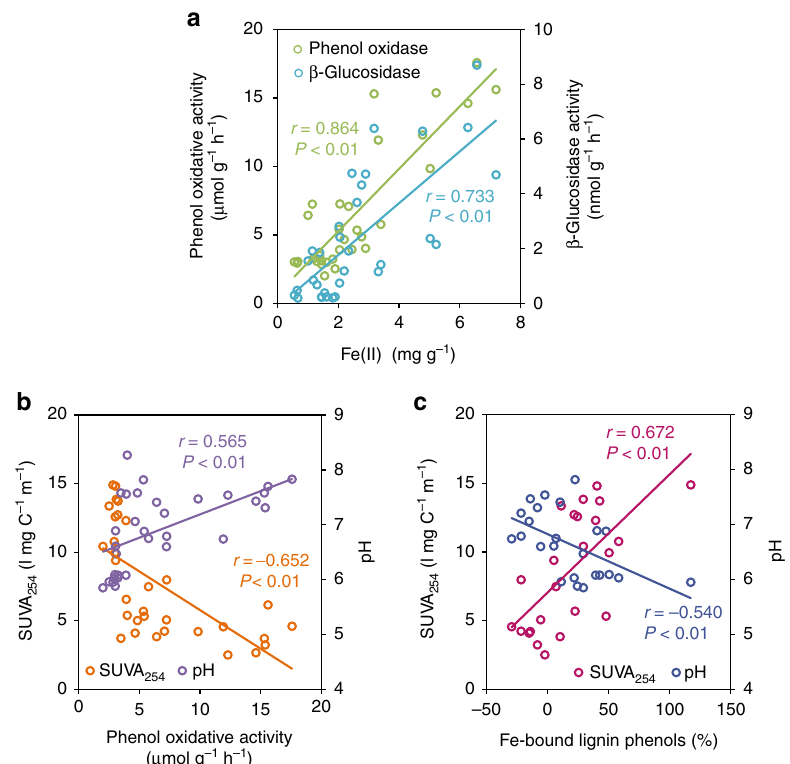
Figure 4 | Variables influencing enzyme activities and iron-bound lignin phenols in the alpine wetland soils. ( a ) Correlations of phenol oxidative and b -glucosidase activities with ferrous iron [Fe(II)] content; ( b ) correlations of soil pH and specific ultraviolet absorbance at 254nm (SUVA 254 ) in the water- extractable organic matter with phenol oxidative activity; and ( c ) correlation between SUVA 254 and iron-bound lignin phenol content. Solid lines indicate significant linear correlations across the entire soil profile ( n ¼ 32 in a , b and n ¼ 24 in c